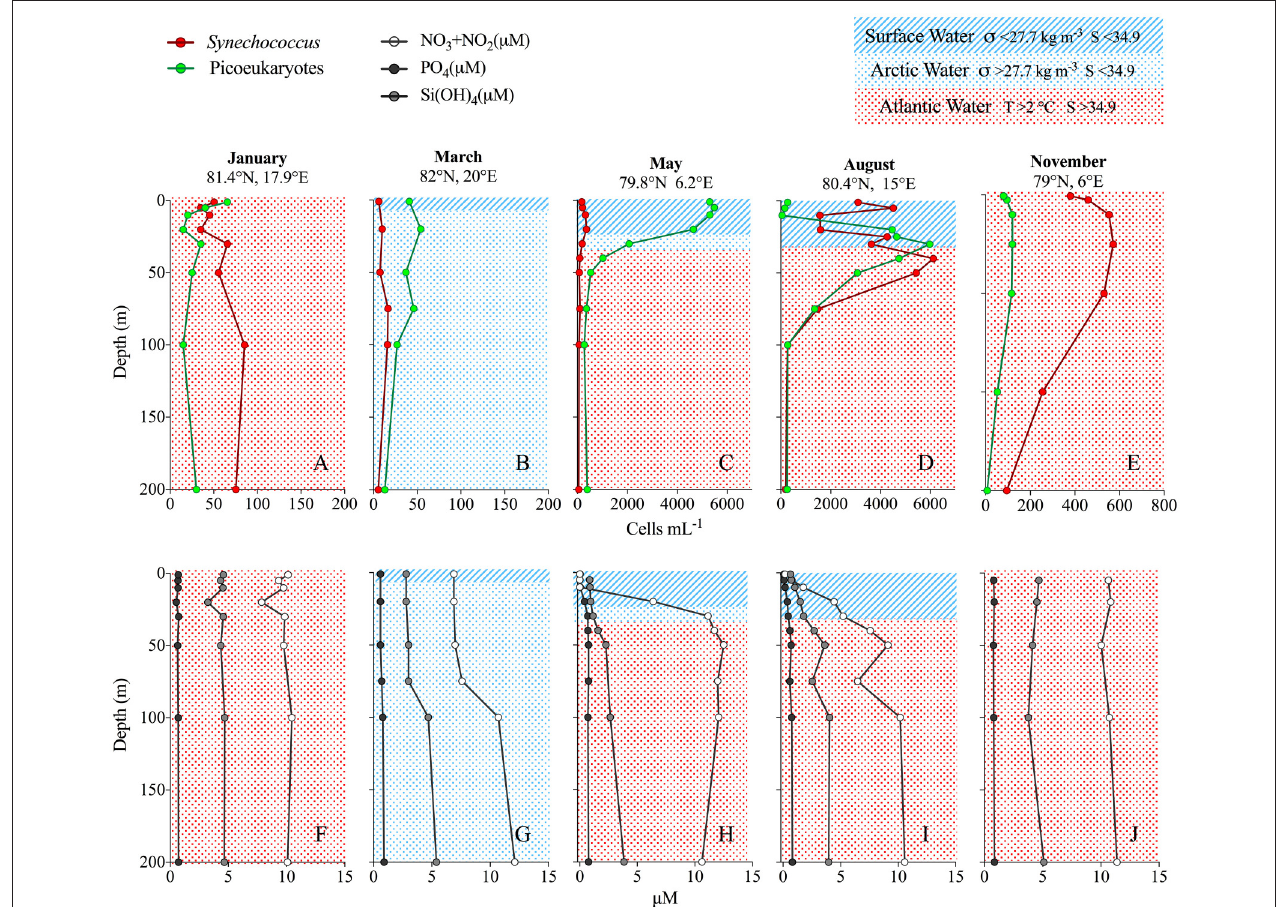
FIGURE 4 | (A–E) profiles of Synechococcus (red) and picoeukaryotes (green) abundance (cells mL − 1 ) from each of the cruises at given coordinates. Notice different scales on the x-axis. (F–J) nutrient concentrations ( µ M) from the same profiles. Background colors and pattern indicate water masses.